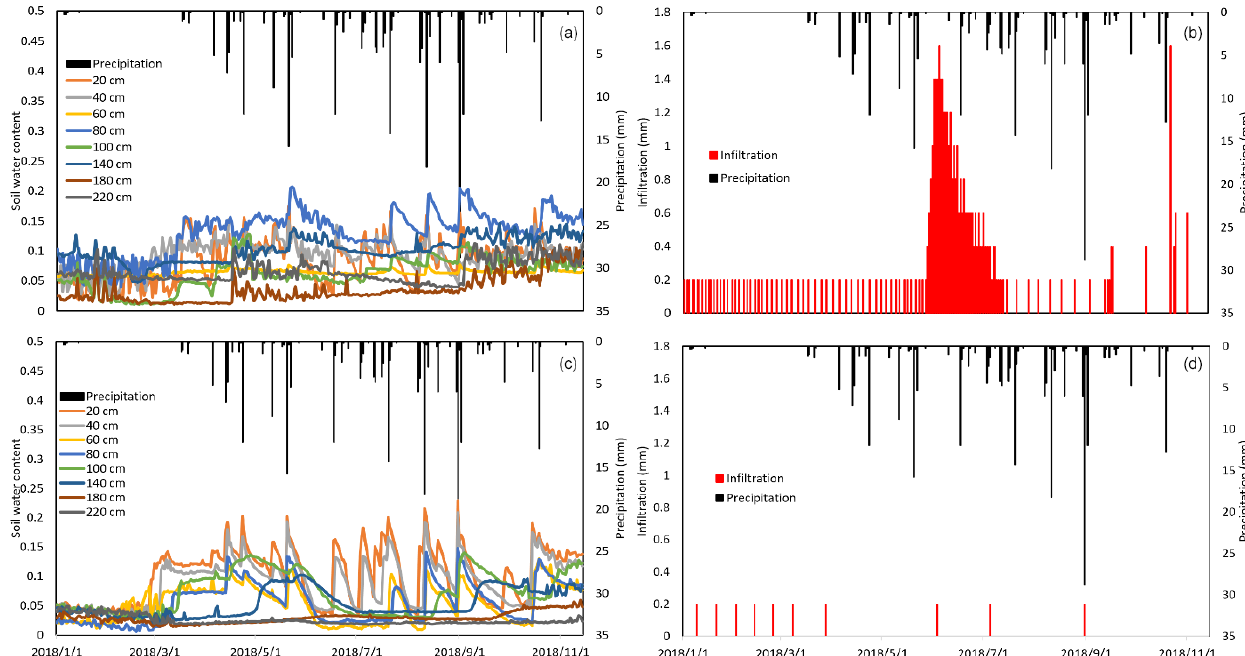
Figure 7. Effects of precipitation on soil moisture (a) and DSR (b) in the bare sandy land plot; effects of rainfall on soil moisture (c) and DSR (d) on the ASK plot, 2018. Table 4. Annual water distribution on the ASK land and bare sand